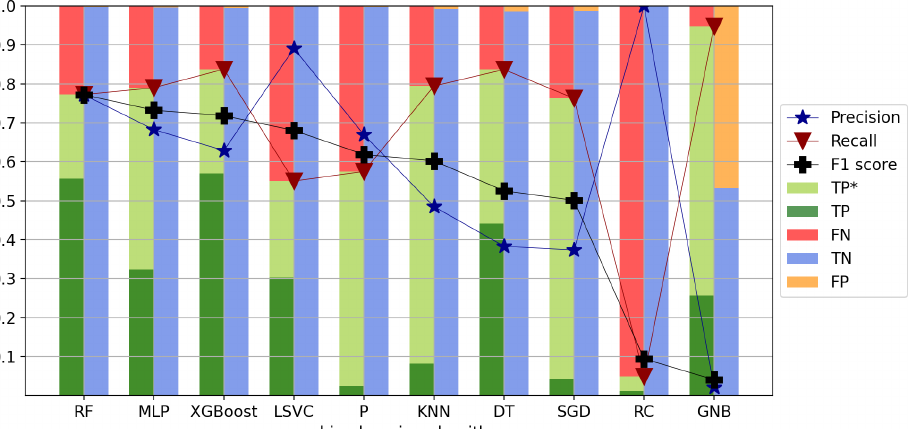
Figure 5. Classification result for testing stations of different machine learning algorithms. Besides the precision, recall and F1 score, two bars per method indicate ratios from the corresponding confusion matrix elements. The left bar covers the performance w.r.t. classifying chunks containing discontinu- ities, while the right bar covers the performance w.r.t classifying chunks without discontinuities. For a description of the individual acronyms and colors, have a look at Figure